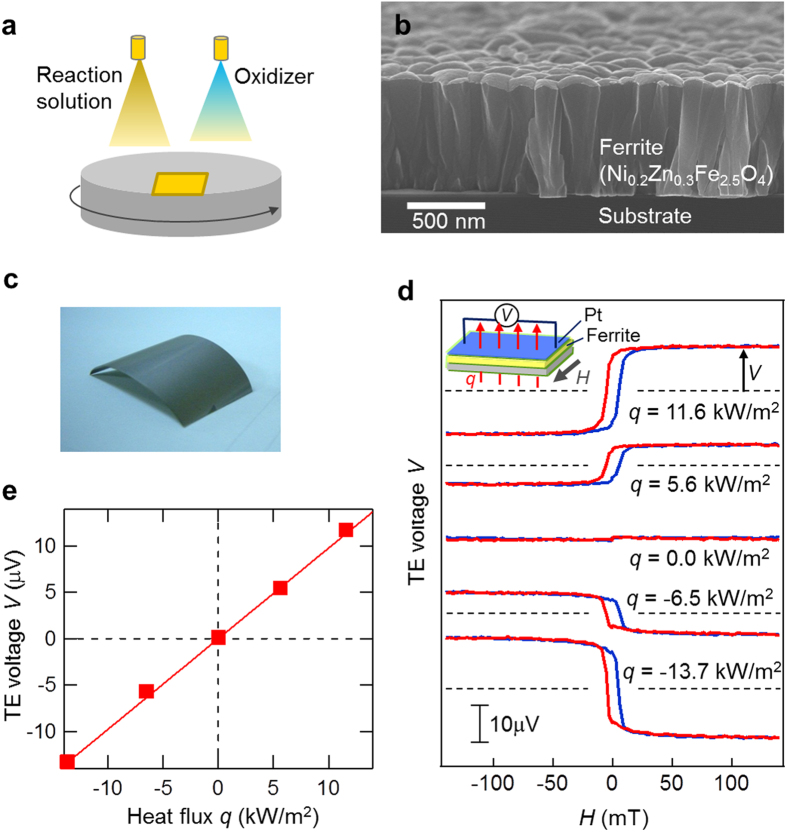
Demonstration of heat-flow-sensing TE sheet based on the LSSE.(a) Schematic of the ferrite-plating method. An aqueous reaction solution (FeCl2 + NiCl2 + ZnCl2) and an oxidizer (NaNO2 + CH3COONH4) are sprayed onto a substrate mounted on a rotating stage. (b) SEM image of a Ni0.2Zn0.3Fe2.5O4 film grown on a SiO2/Si substrate using the ferrite-plating method. The film exhibits a columnar-crystal structure. The typical diameter of the columnar grains is approximately 100 nm. (c) Photograph of an LSSE-based flexible TE sheet, in which a Pt/Ni0.2Zn0.3Fe2.5O4 film was formed on a 25-μm-thick polyimide substrate. (d) TE voltage V as a function of an external magnetic field H, measured when a heat flux q was applied across the TE sheet. The sign of V is reversed, when the sign of H or q changes. (e) TE voltage from the TE sheet as a function of q. From the fitting with the solid line, the heat-flow sensitivity of this TE sheet was V/q = 0.98 nV/(W/m2).